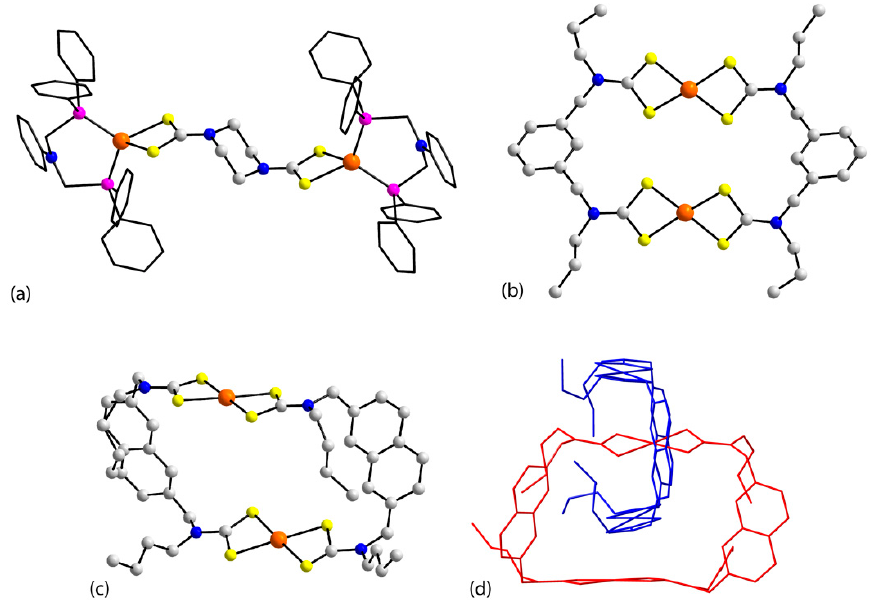
Figure 5. The di-nuclear molecules of ( a ) [(Ph 2 PCH 2 N(Ph)CH 2 PPh 2 )Cu] 2 (L 2 ) in 22 , ( b ) Cu 2 (L 9 ) 2 in 24 and ( c ) [Cu 2 (L 9 ) 2 ] + in 25 . ( d ) The catenane, {[Cu 2 (L 9 ) 2 ]} 22+ , in 25 in stick form. The carbon atoms of the Ph 2 PCH 2 N(Ph)CH 2 PPh 2 molecules are illustrated in stick mode.